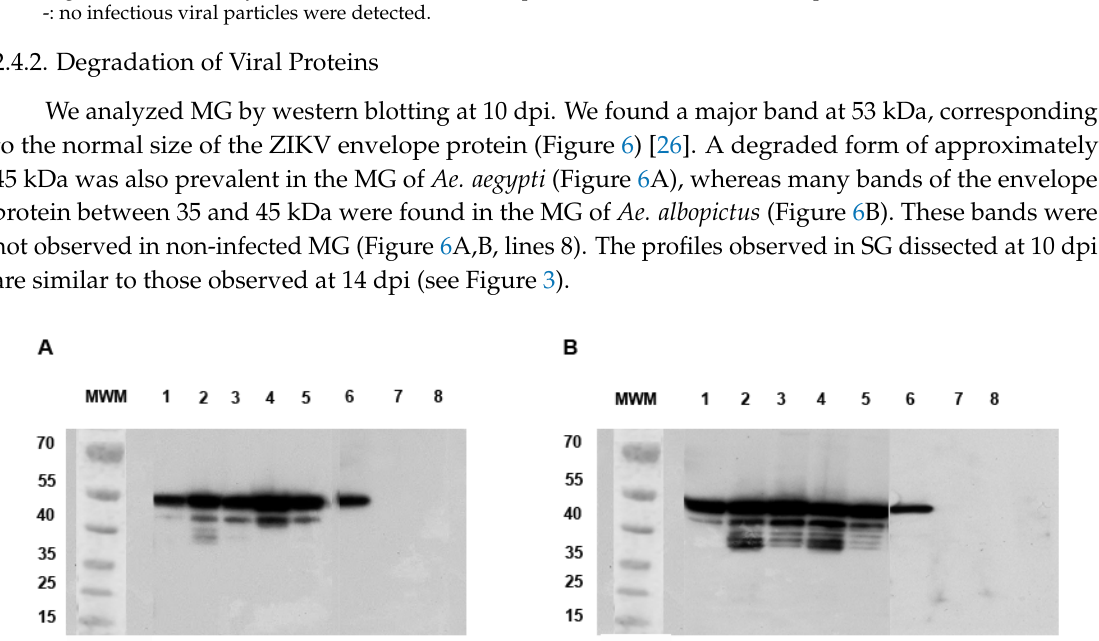
Figure 6. Western blots comparing the degradation of ZIKV E protein in Ae. aegypti and Ae. albopictus at 10 dpi. ( A ) Lines 1 to 5: Ae. aegypti MG infected by ZIKV; ( B ) Lines 1 to 5: Ae. albopictus MG infected by ZIKV. Controls are shown in each figure and consist of ZIKV-infected Vero cell lysate (positive control, lines 6A and B), L15 medium (lines 7A and B), and non-infected MG (lines 8A and B). MWM: molecular weight markers are indicated in kDa.